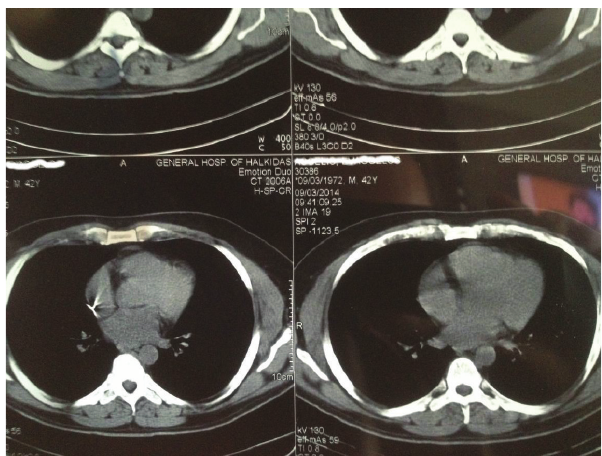
Figure 1: X-ray of the left femoral bone. Multiple pellets are visible in the surrounding soft tissues. No bone fracture.